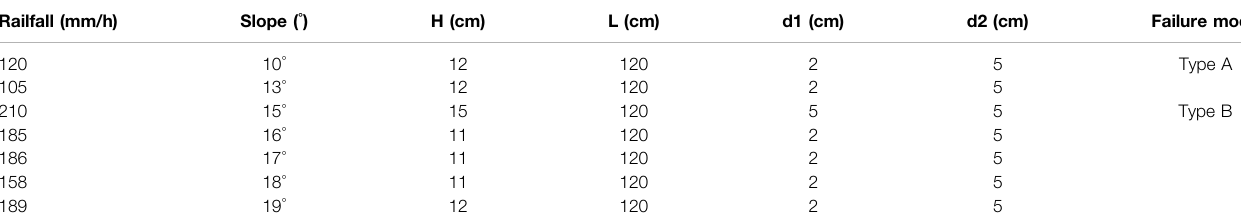
TABLE 1 | An overview of the tests.